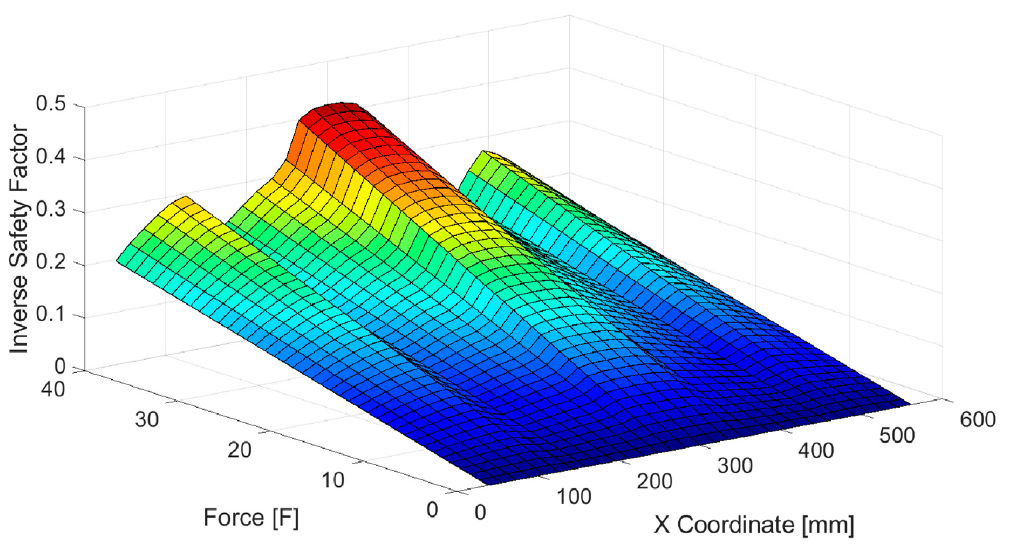
Figure 10. Surface plot of the inverse safety factor as function of the value and location of the acting force.